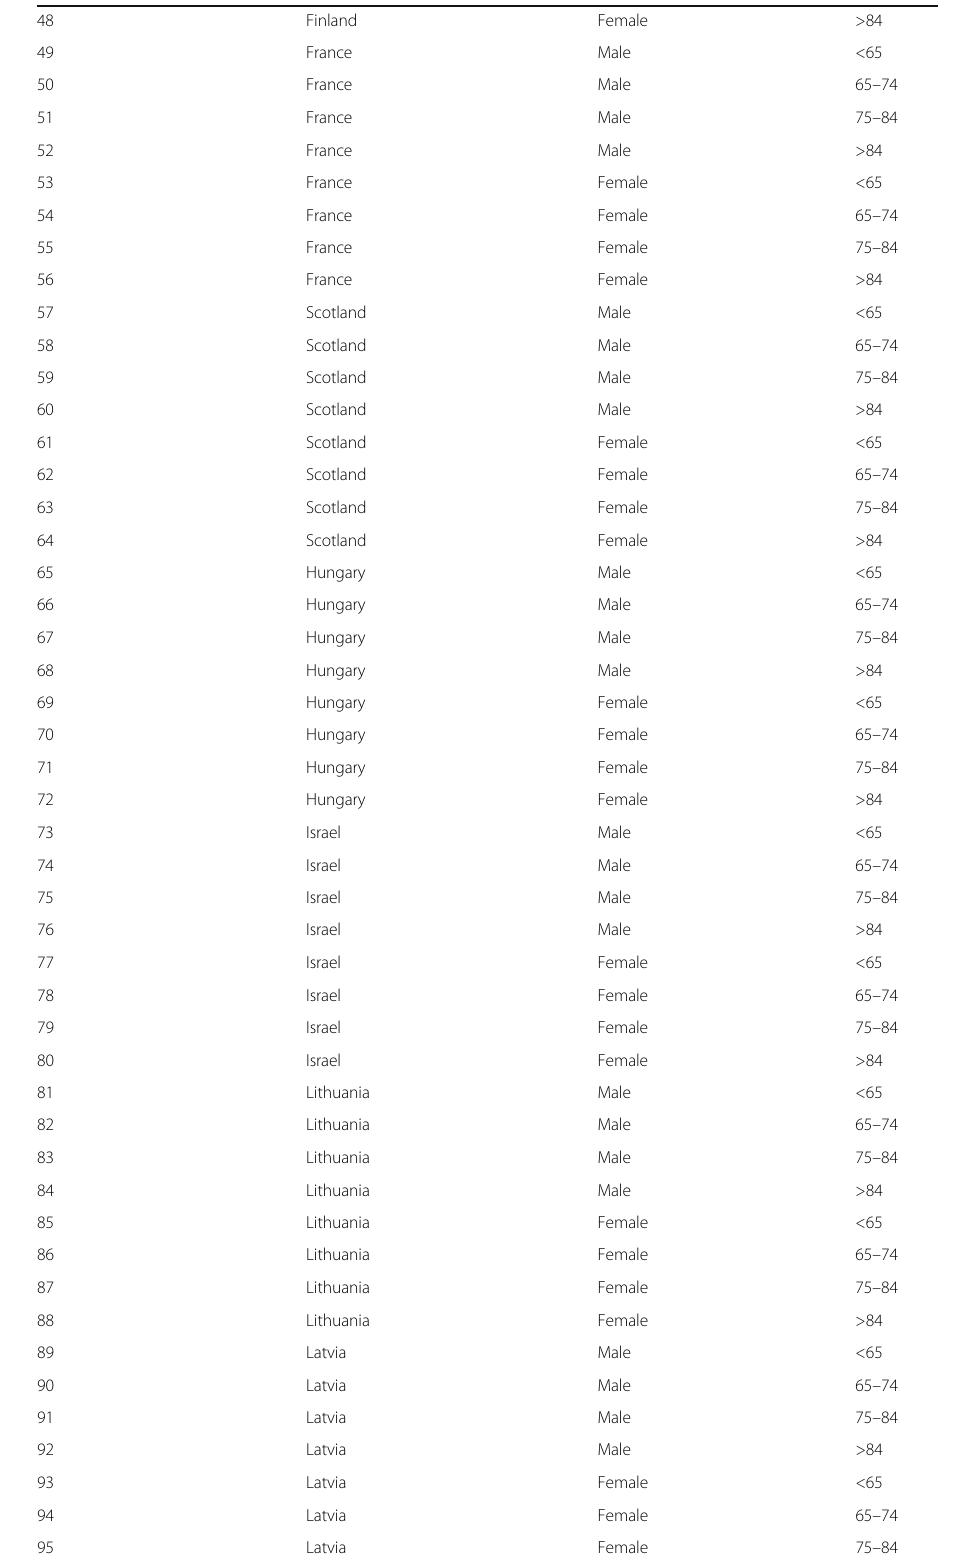
Table 3 Order of time series used in the analysis